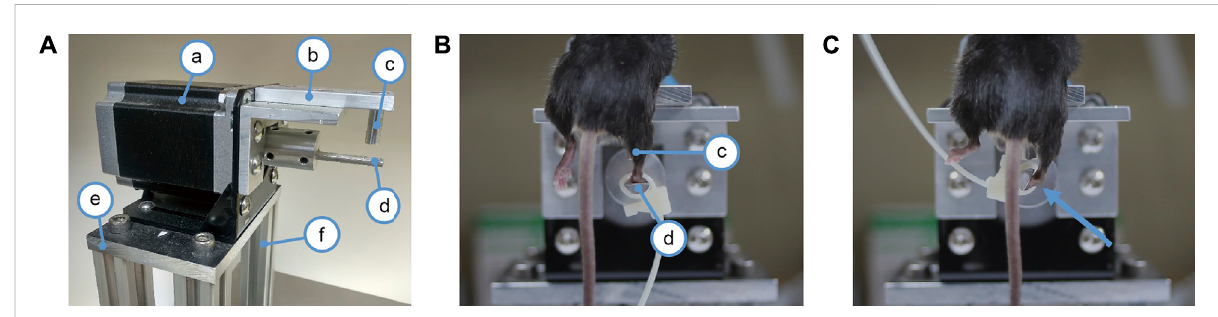
FIGURE 1 Device for mechanical ankle sprain. (A) photograph showing the device for spraining the ankle, a: a stepper motor, b: bed platform for the mouse, c: bed post for restraining the mouse shin to the machine, d: foot rest rod connected to the motor shaft for securing mouse foot to the motor, e: base plate to mount the motor, f: posts to support the motor. (B) photograph showing a mouse mounted on the ankle spraining machine. Therightshinisheldagainstthebedpost(c)bytheexperimenter ’ shand(notshown)torestrictshinmovement.Therightpawissecuredonthe foot rest rod (d) by a cable tie. In photo (B) , the mouse foot is parallel to the fl oor and the mouse ankle has not yet been rotated. (C) photograph showing how much the motor shaft spins to sprain the ankle, it spins 117 ° in the inversion direction as indicated by an